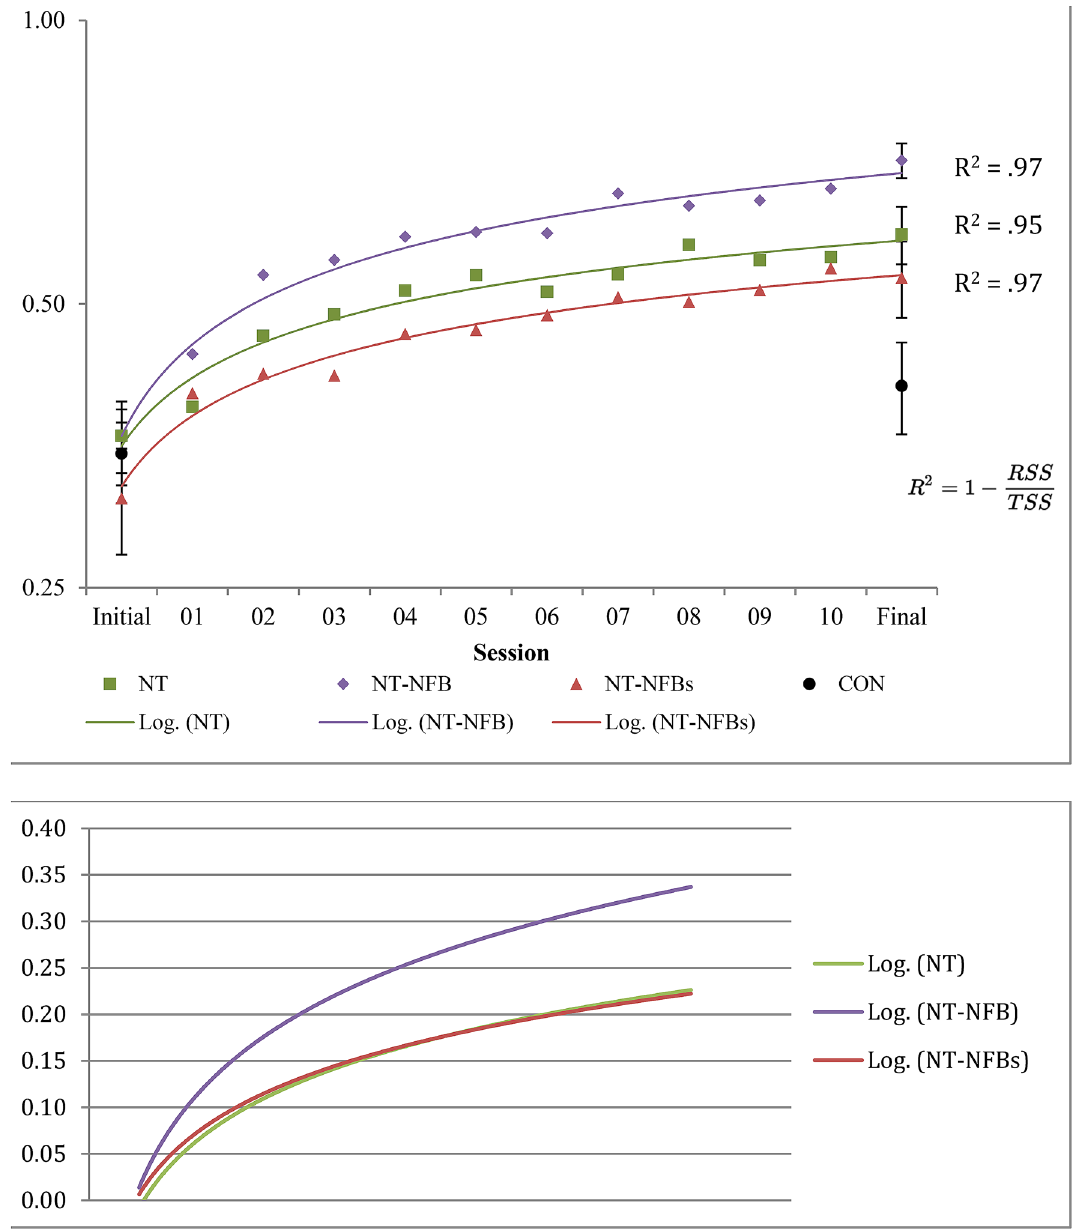
Figure 3. 3D-MOT Geometrical Speed Threshold Means on a log scale. Above: Error bars represent standard error and are only presented for Initial and Final sessions in order to maintain image clarity. Standard error for training trials varied between .03 and .05 for the NT group, .02 and .04 for the NT-NFB group, and .04 and .06 for the NT-NFBs group. Lines represent the log regression and the R 2 corresponds to the amount of variance explained by the fit. (RSS = residual sum of squares, TSS = total sum of squares). Below: Normalized learning curves calculated by taking each individual session score and subtracting the baseline (initial session)